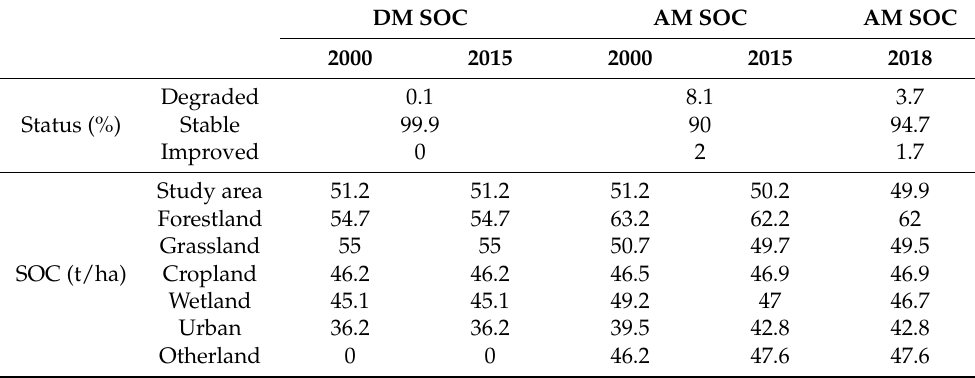
Table 4. The soil organic carbon (SOC) content for the default (DM) and adapted methods (AM) for the baseline period from 2000 to 2015 as well as for the first monitoring period of